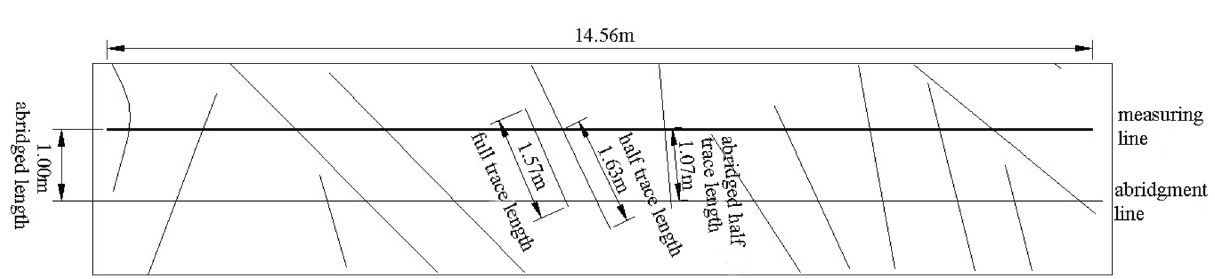
Figure 3. The diagram of the relationship between measuring line and trace